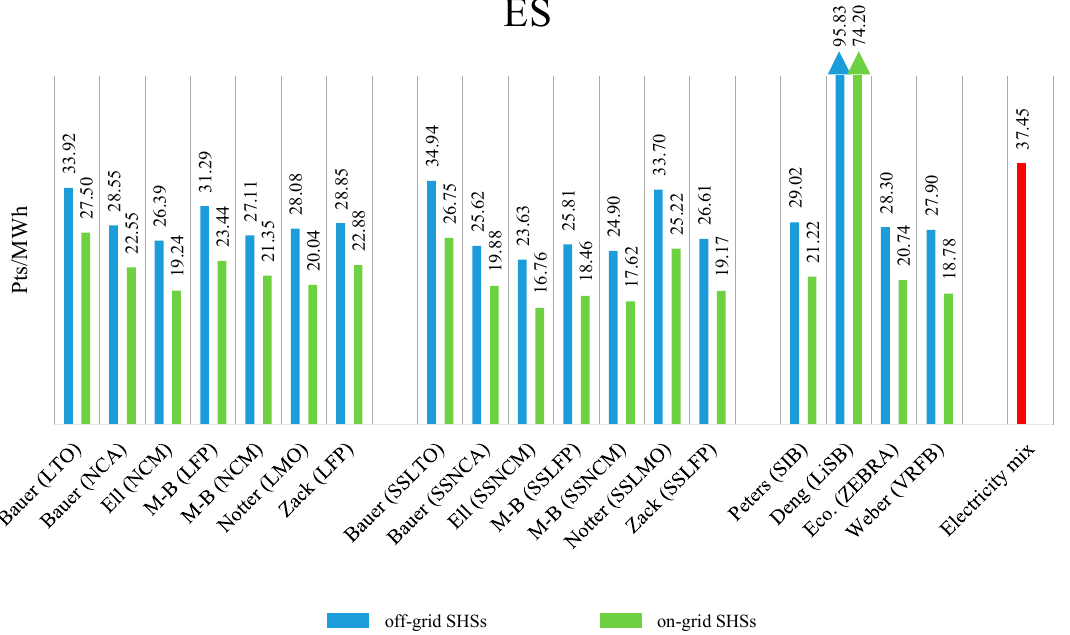
Figure 5. LCA impact values of SHSs in Denmark as single scores.